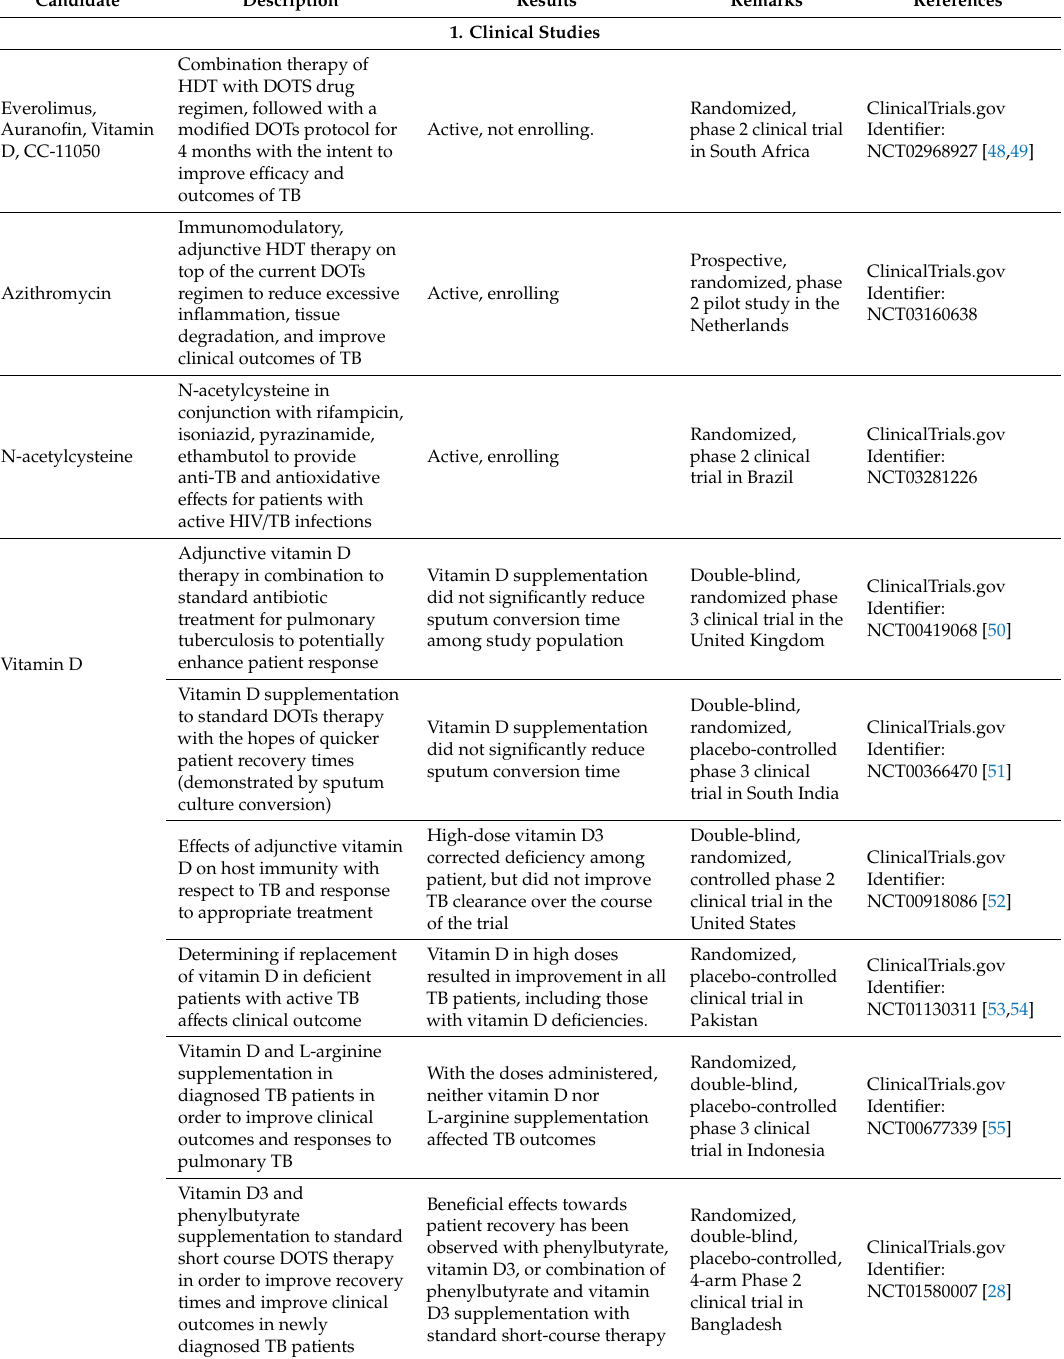
Table 1. Host-Directed Therapies against TB: Recent Clinical and Additional